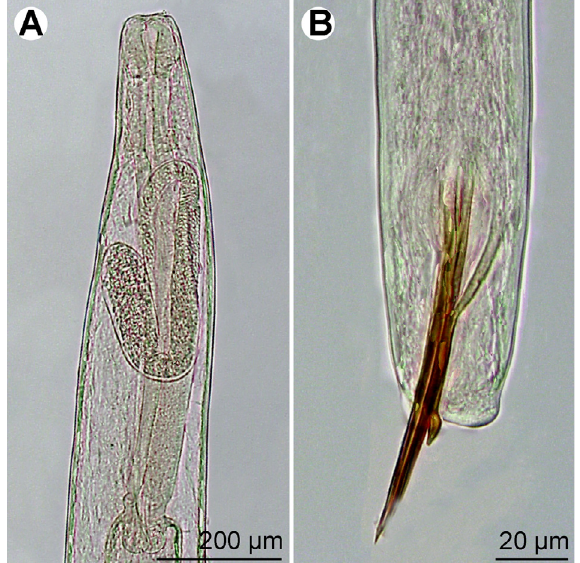
Figure 3. Philometra protonibeae n. sp. from Protonibea diacan- thus , light microscope micrographs. A: Anterior end of nongravid female, lateral view. B: Posterior end of male, lateral